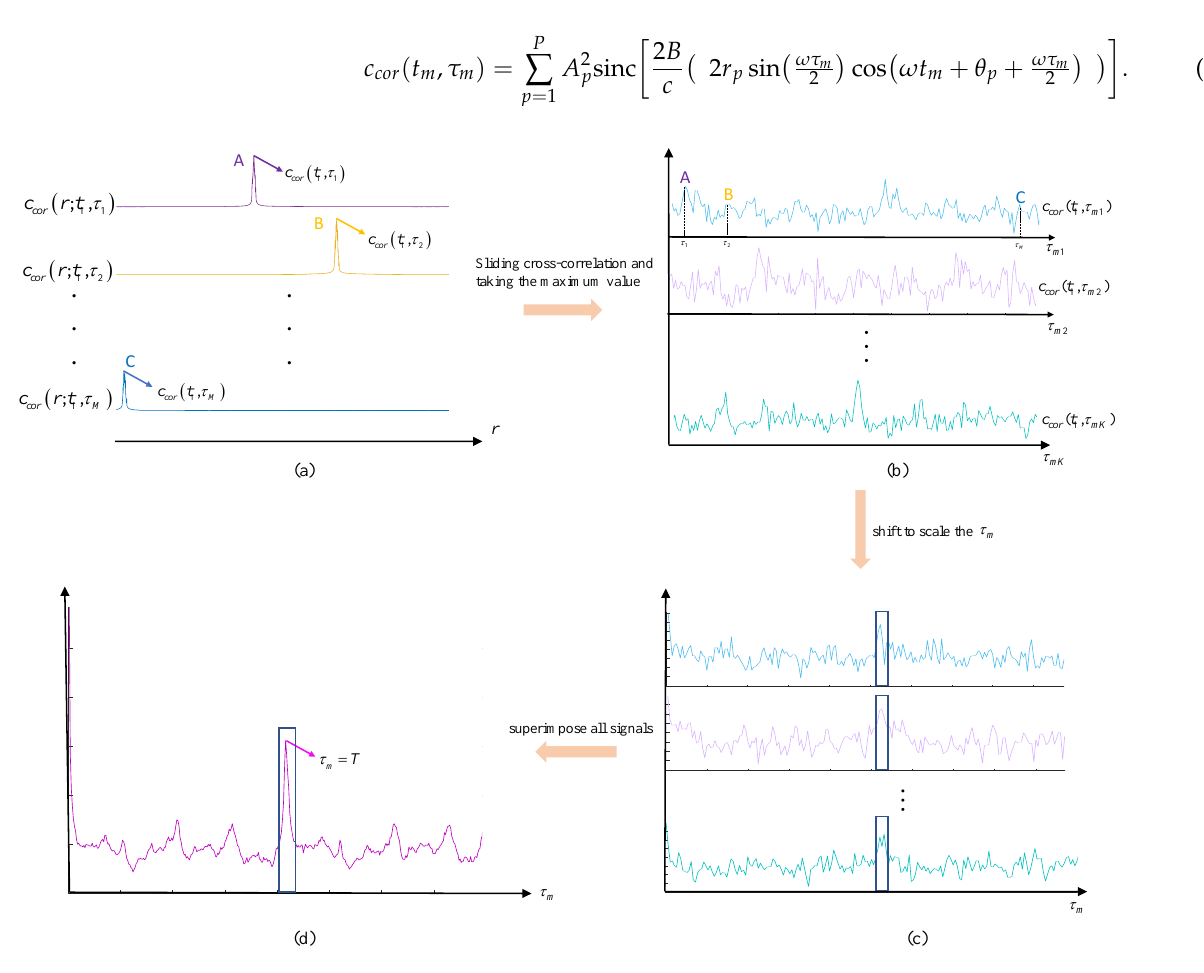
Figure 3. Illustration of rotation period estimation procedure of the proposed method. ( a ) Slid- ing cross-correlation between single signal and all signals. ( b ) c cor ( t m , τ m ) . ( c ) Results of shifting c cor ( t m , τ m ) . ( d ) Results of period